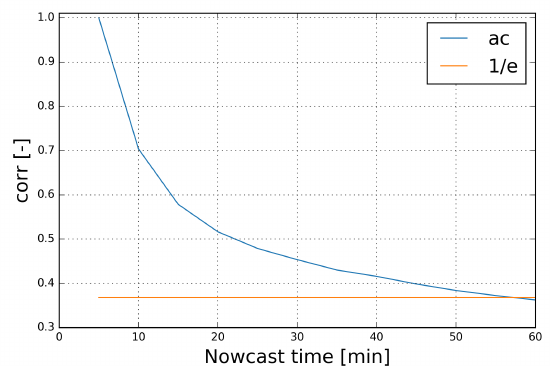
Figure 4. Autocorrelation of precipitation field as function of the delay expressed in minutes for a sample of 200 “rainy”